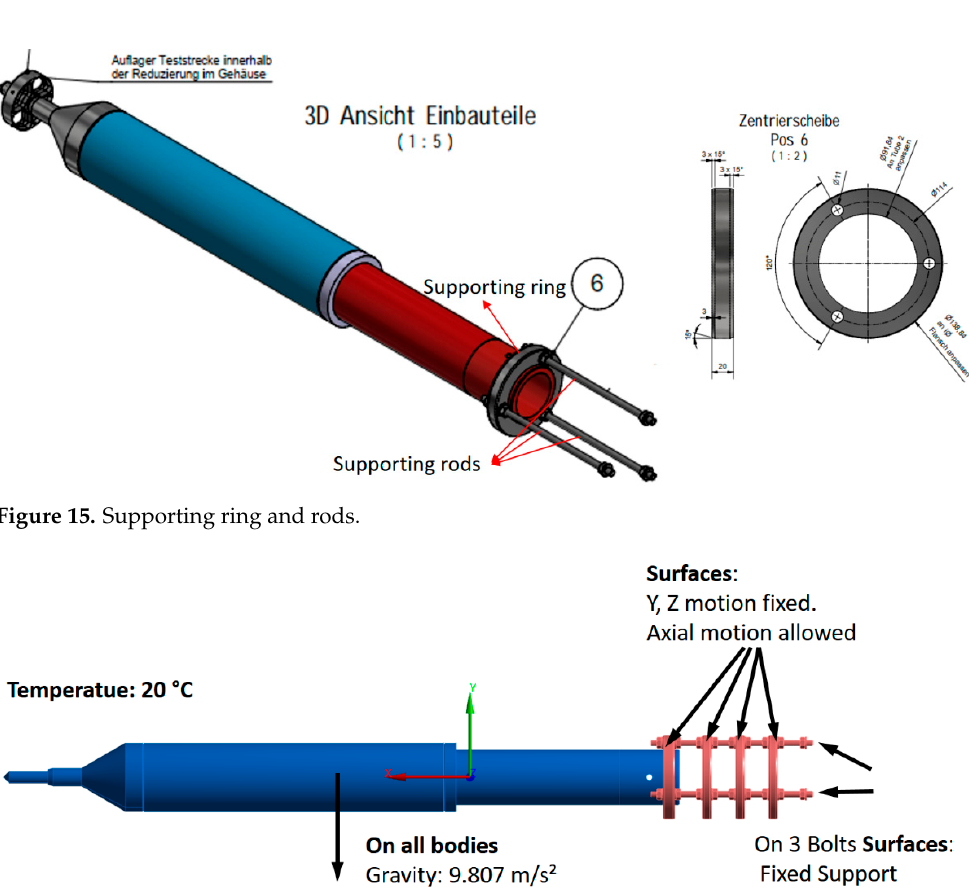
Figure 16. Boundary conditions case 2. The deflection of the tube insert is shown in Figure 17.